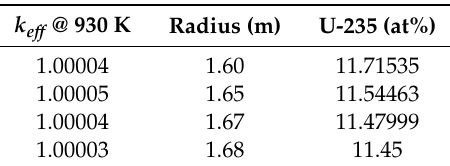
Figure 8. Criticality of the 2D system over burnup for different system radii for the heavy metal rich composition 20%NaCl-56.35%UCl 4 -23.65%UCl 3 . Table 5. Data (initial criticality and required uranium 235 enrichment) for the dimensional iteration for the averaged fuel temperature of 930 K for the heavy metal rich system.